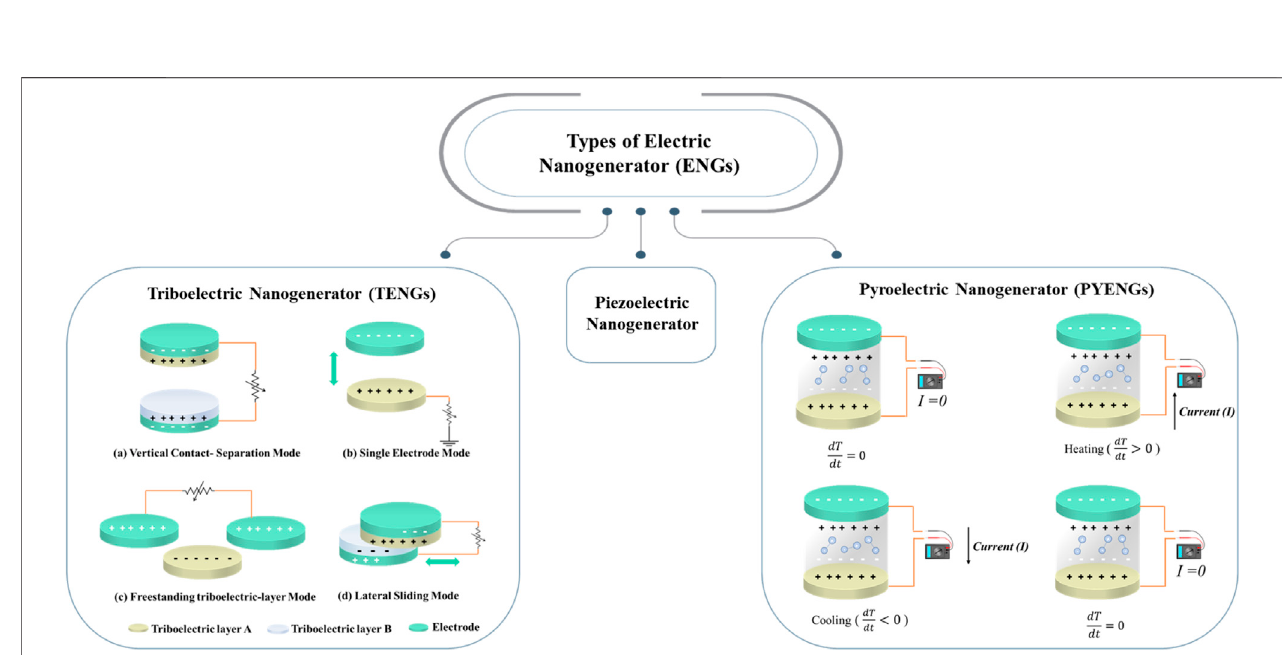
FIGURE 5 | Illustrates the types of nanogenerators: Triboelectric (TENGs), Piezoelectric, and Pyroelectric (PYENGs) nanogenerators. Left schematic diagrams showTENGsoperationmodes.WhilerightschematicdiagramillustratestheworkingmechanismofPYENGs.InTENGsoperationmodes. (A) verticalcontactseparation mode, (B) freestanding triboelectric layer mode, (C) single electrode mode.